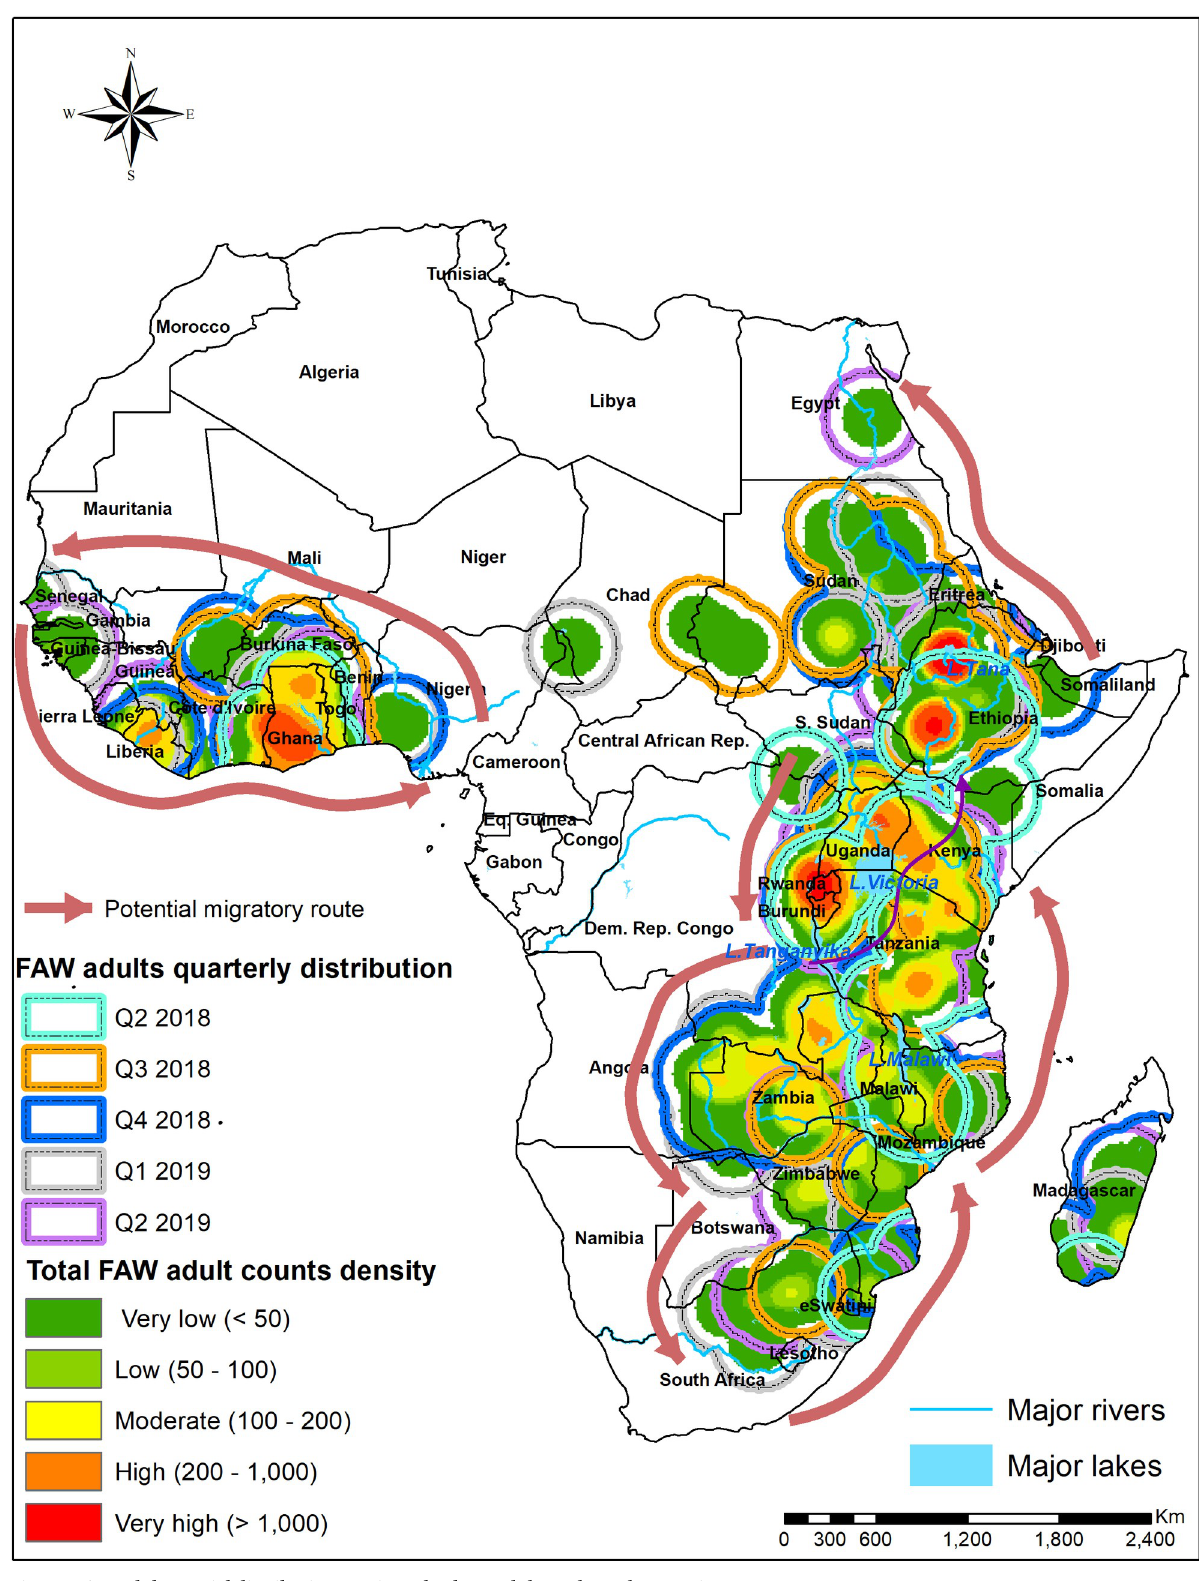
Fig 12. FAW adults spatial distribution consistently observed throughout the years in 2018 to 2019.